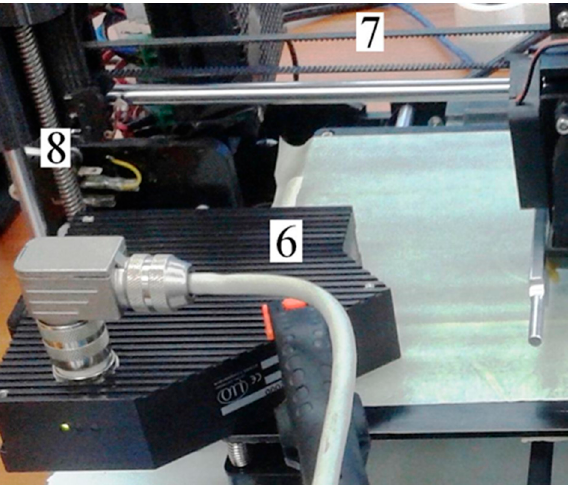
Figure 2. A partial view of the setup with optical sensor on x -axis; 6-optical sensor; 7-toothed belt for x -axis displacement; 8-s screw for z -axis displacement.